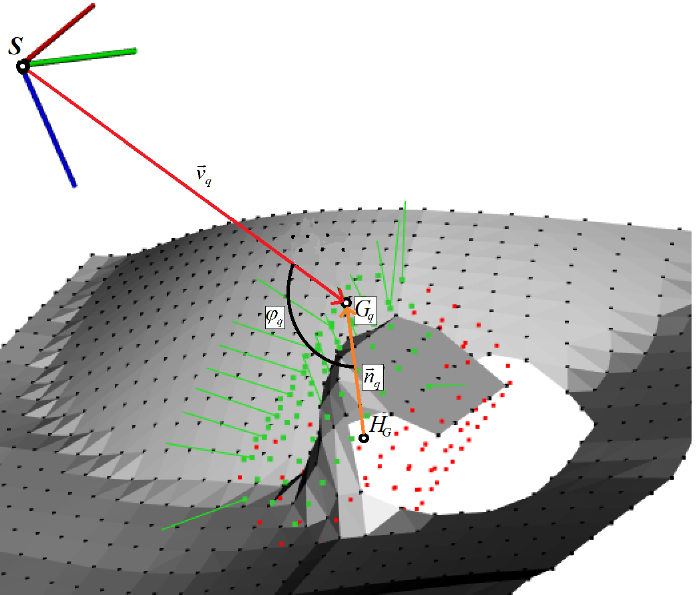
Figure 3. Filtered (green) and discarded (red) point clouds near the point cloud of the object surface.